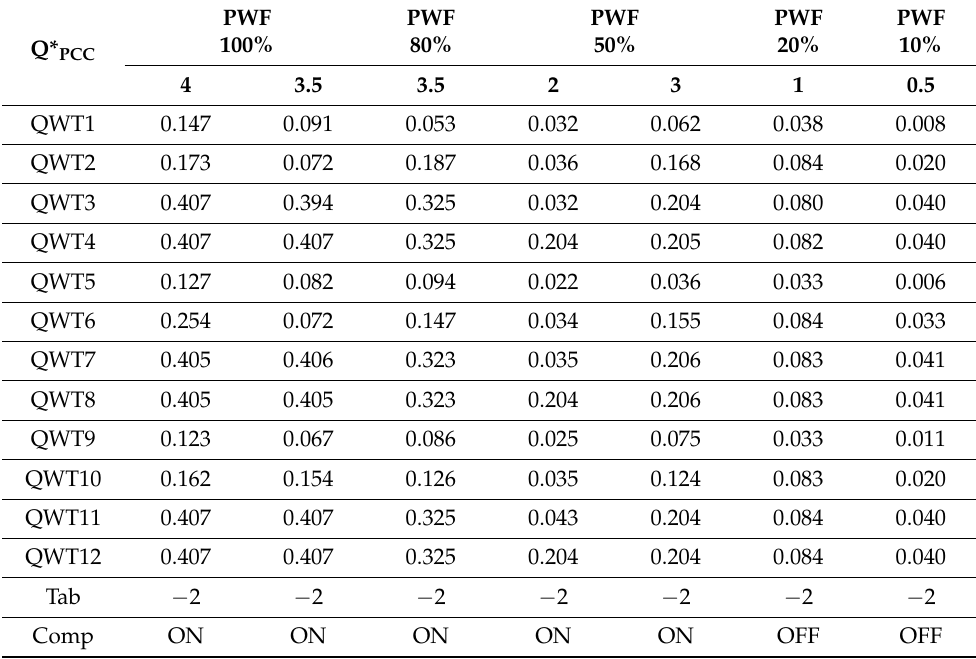
Table 6. Results of option I for reactive power WTs, tap position, and compensation